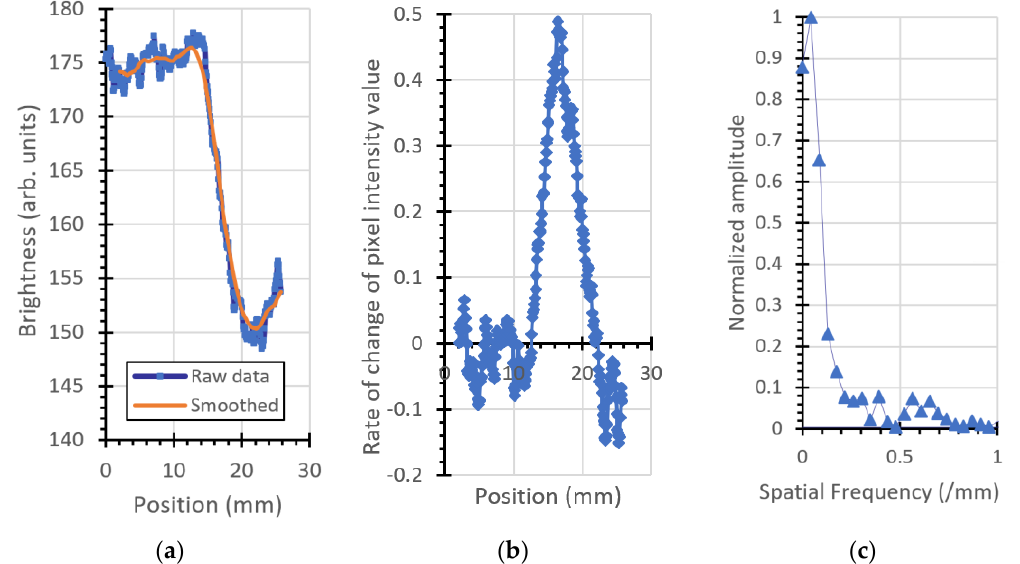
Figure 7. Vertical left edge of the plastic phantom: ( a ) ESF, ( b ) LSF (inverted for clarity), and ( c ) MTF.